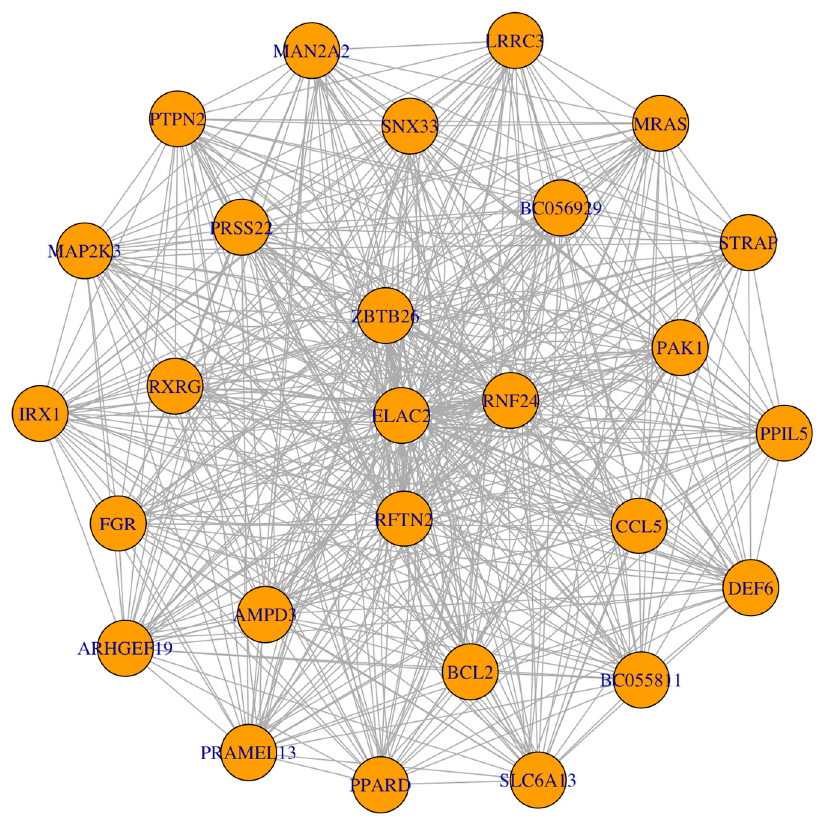
Figure 4. Visualization of the co-expression of genes in the co-expression module. The dot is the gene node, and the line connecting the two dots indicates the interaction between two genes.